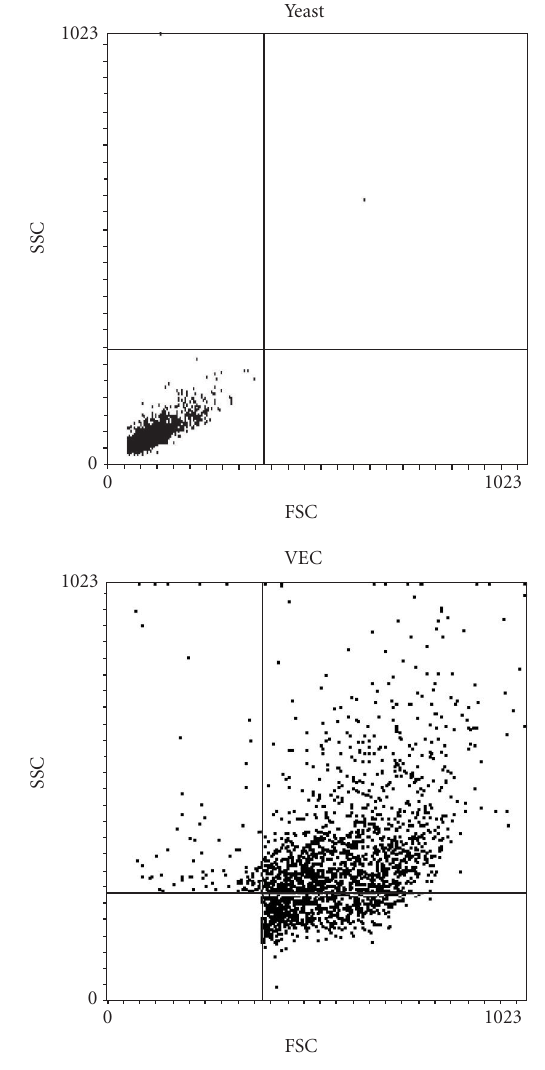
Figure 3: Cytometer setup that permits discrimination of yeast and vaginal epithelial cells (VEC) on the basis of cell geometry. Upper panel shows that 99 . 7% of yeast cells are segregated into the lower left quadrant. The FSC-SSC distribution of VEC is predominantly in the upper- and right-hand quadrants. We therefore created a gate that includes the upper- and right-hand quadrants in order to ana- lyze the